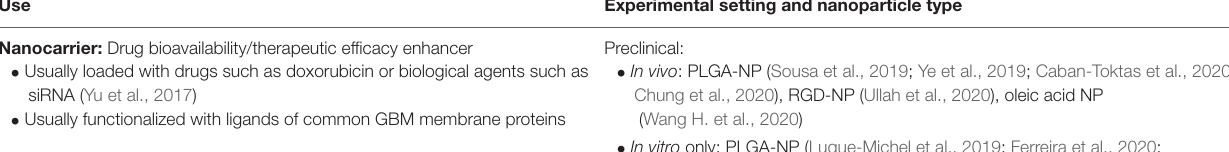
TABLE 3 | Advances in the uses of nanoparticles in glioma therapy and diagnosis.